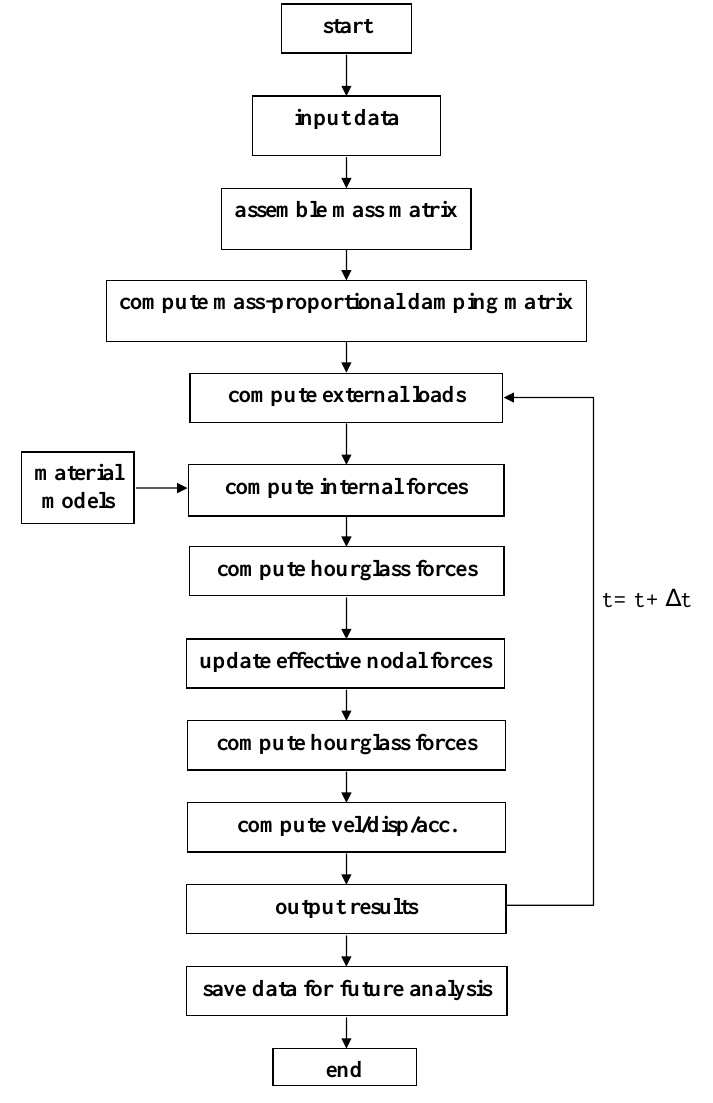
Fig. 3. Computational procedure of dynamic